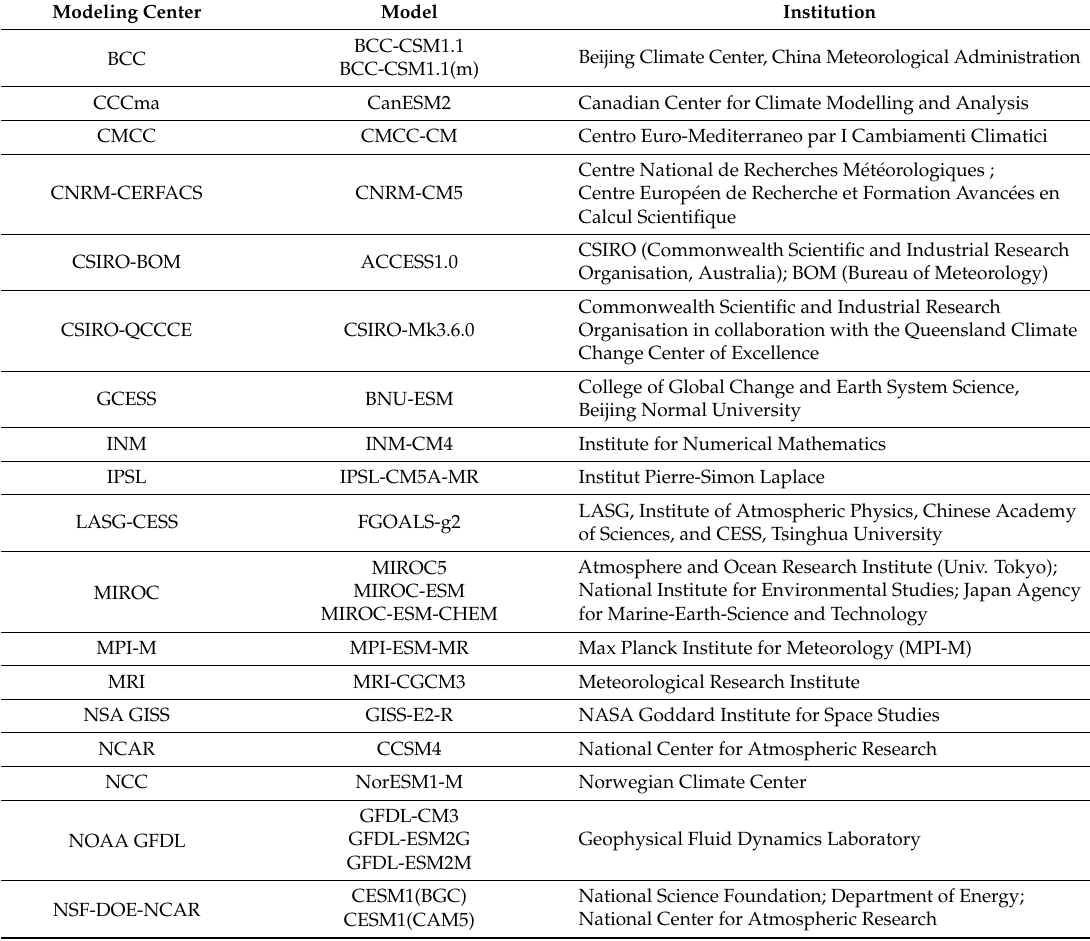
Table 1. GCM model considered from CMIP5 experiment. All considered projections are obtained for the Representative Concentration Pathways